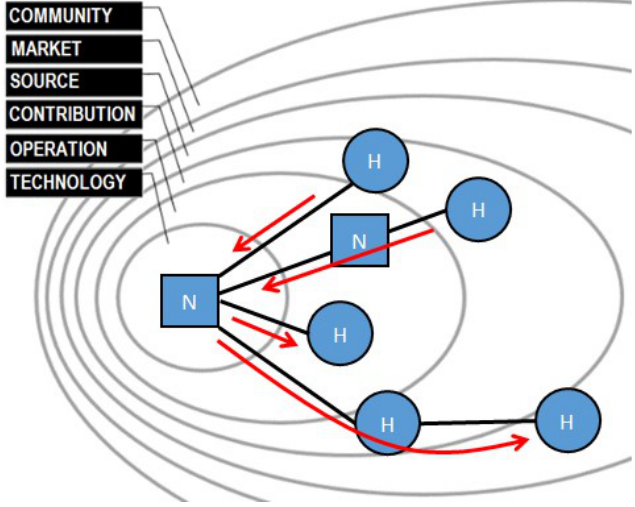
Fig. 20. Stakeholders affecting and being affected by the system, direct or indirectly.